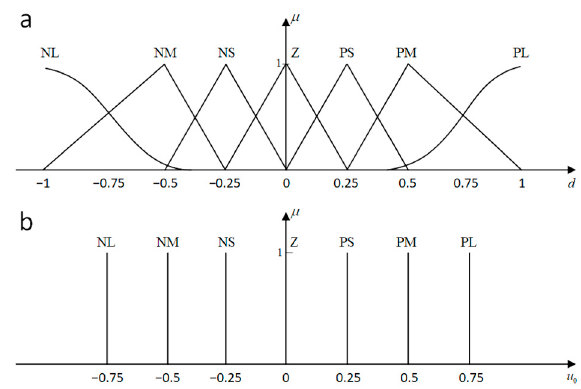
Table 2. Rule table for the above SIFOFLC.